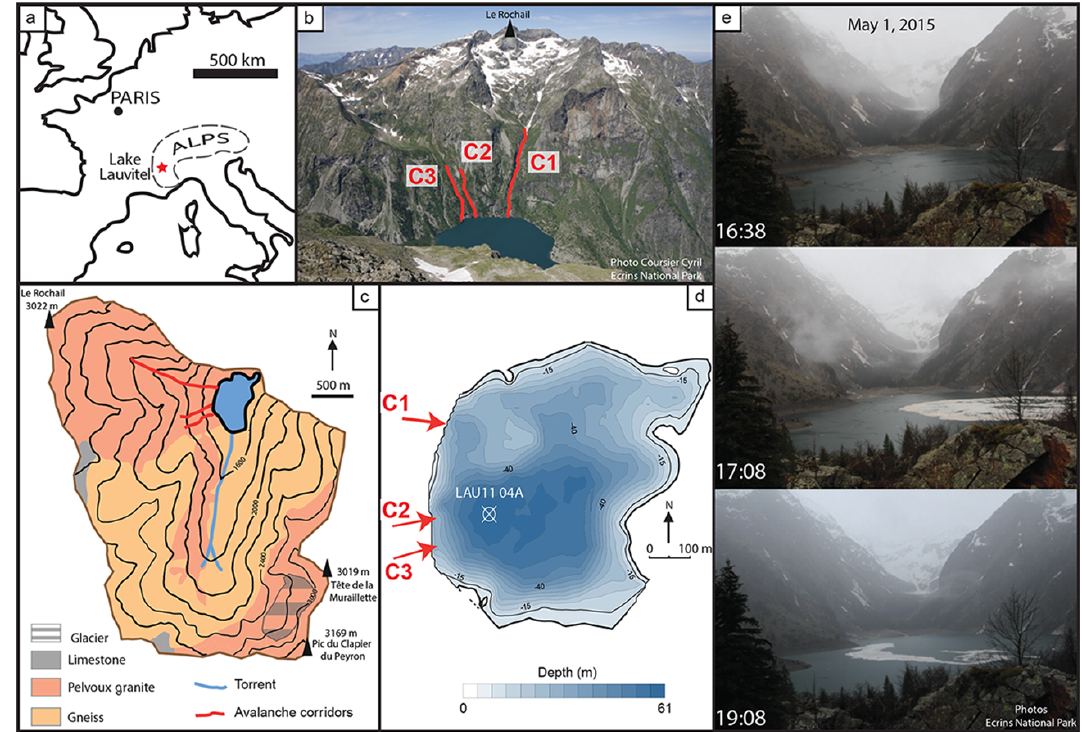
Figure 1. (a) Location of Lake Lauvitel. (b) Photo looking westward toward the location of the three avalanche corridors in the Lake Lauvitel watershed. (c) Simplified geologic map of the Lake Lauvitel watershed. (d) Lake Lauvitel bathymetric map and location of the three avalanche corridors and position of the LAU1104A coring point. (e) Photos of the lake looking to the south, with an avalanche entering the lake via the C1 corridor on 1 May